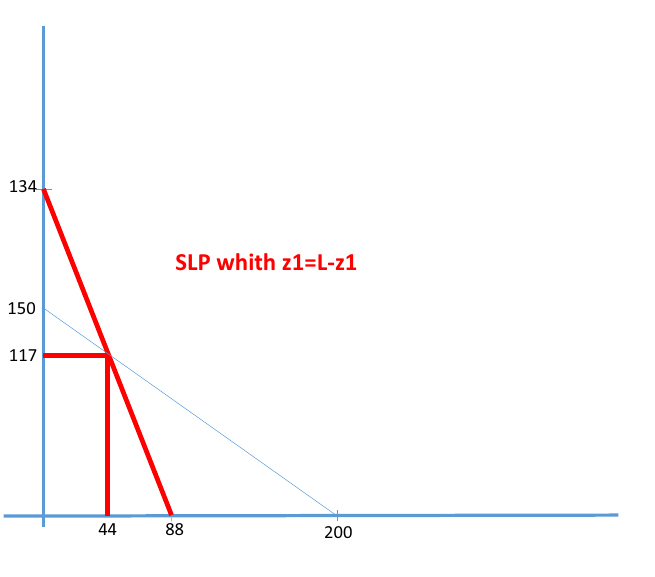
Figure 7. SPL where the two parts of the ladder are